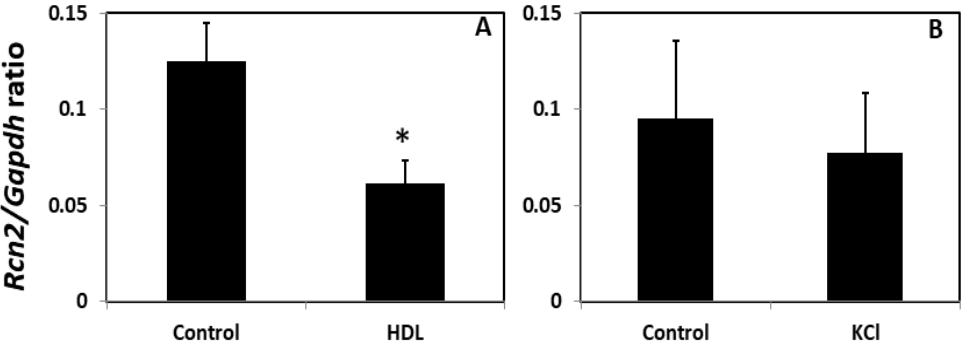
Figure 6. Real-time PCR analysis of Rcn2 expression (normalized to Gapdh) in endothelial cells isolated from B6- Apoe − / − mice. Cells received a 24-h treatment with 45 mg/dl of HDL ( A ) or 12 mM of KCl ( B ) in final concentrations. Values are means ± SD of in cells from 3 to 5 mice. * p < 0.05. The Student t test was performed to determine statistical significance in Rcn2 expression levels in cells treated with and without HDL or KCl.